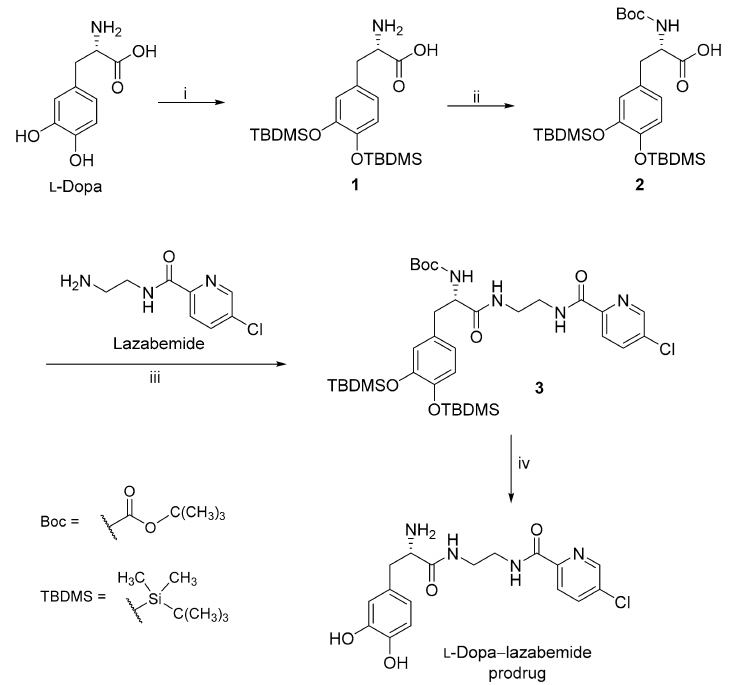
Figure 3. The protection of L -dopa and the synthesis of the L -dopa–lazabemide prodrug. Key: (i) r.t., 18 h, DBU, TBDMS-Cl; (ii) THF/H 2 O, NaHCO 3 , di- tert -butyl dicarbonate (Boc 2 O); (iii) BOP, NMM, CH 2 Cl 2 , 24 h; (iv) 4 M HCl (dioxane), 48 h, 55 ◦